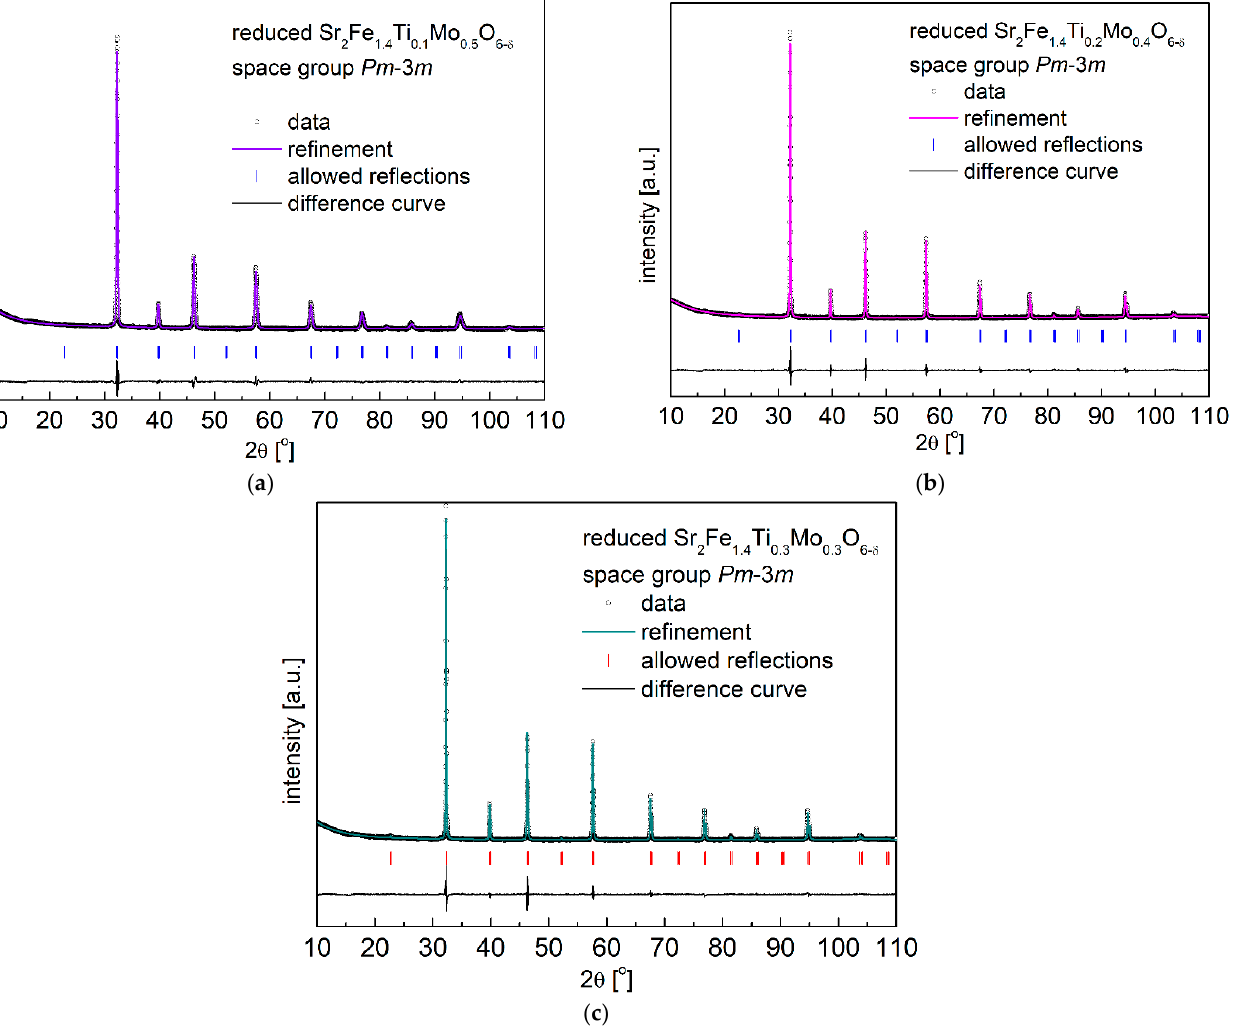
Figure 2. XRD patterns recorded for reduced ( a ) Sr 2 Fe 1 . 4 Ti 0 . 1 Mo 0 . 5 O 6 −δ ; ( b ) Sr 2 Fe 1 . 4 Ti 0 . 2 Mo 0 . 4 O 6 −δ and ( c ) Sr 2 Fe 1 . 4 Ti 0 . 3 Mo 0 . 3 O 6 −δ oxides in 5 vol.% H 2 /Argon at 1200 °C for 10h.